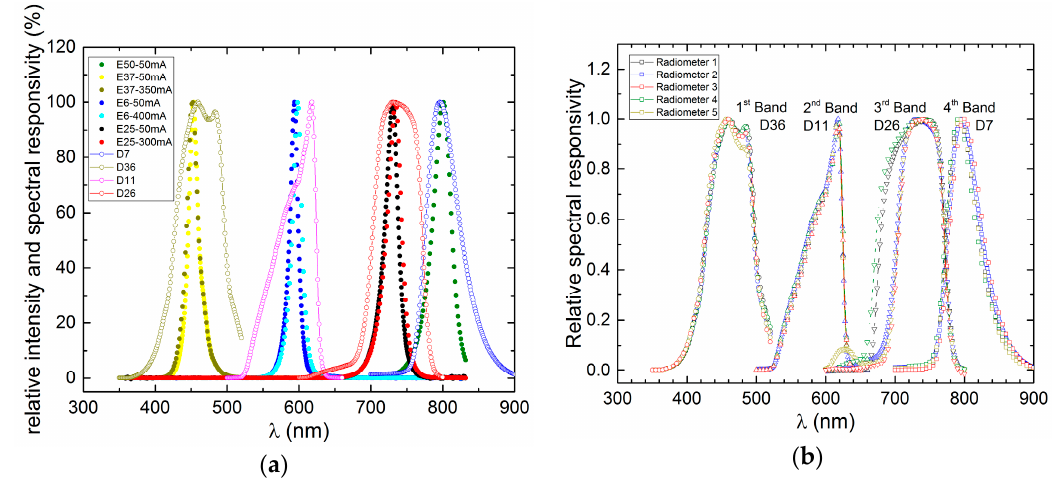
Figure 6. Normalized emission and detection spectra of the selected LEDs for: ( a ) one of the final radiometers; and ( b ) all five of the radiometers. Each radiometer mounts LED samples of the same family and they show good repeatability in terms of spectrum shape. The narrowing in the third band is due to the presence of a dome on top of the LED detector mounted in three of the radiometers.